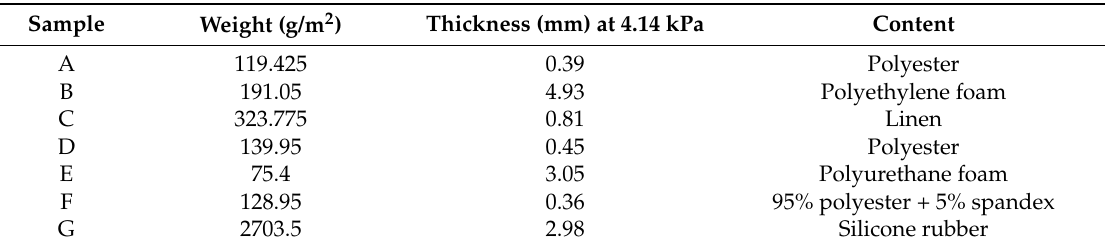
Table 2. Structural parameters of seven typical samples for objective and correlation tests.